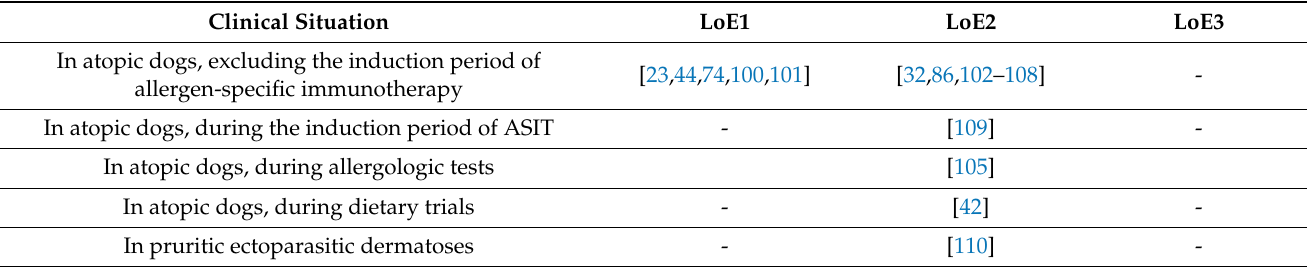
Table 6. Level of evidence (LoE) of individual studies of the use of oclacitinib in different clinical